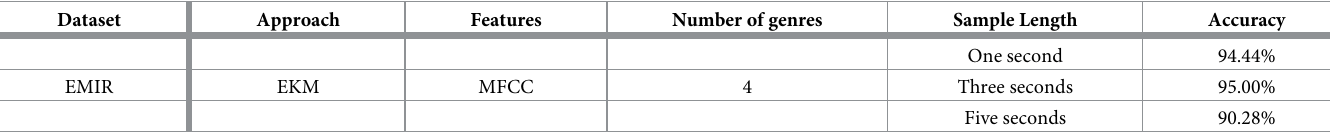
Table 3. Experiment 2: EKM model accuracy using 1s, 3s and 5s sample lengths, MFCC features and EMIR data.